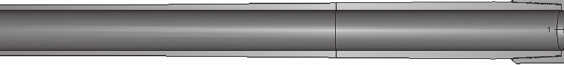
Figure 13. Lateral view of the model.